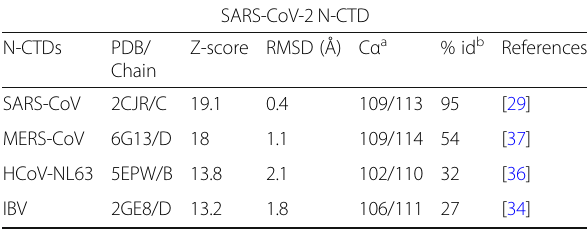
Table 2 Structural comparisons of the SARS-CoV-2 N-CTD with other homology